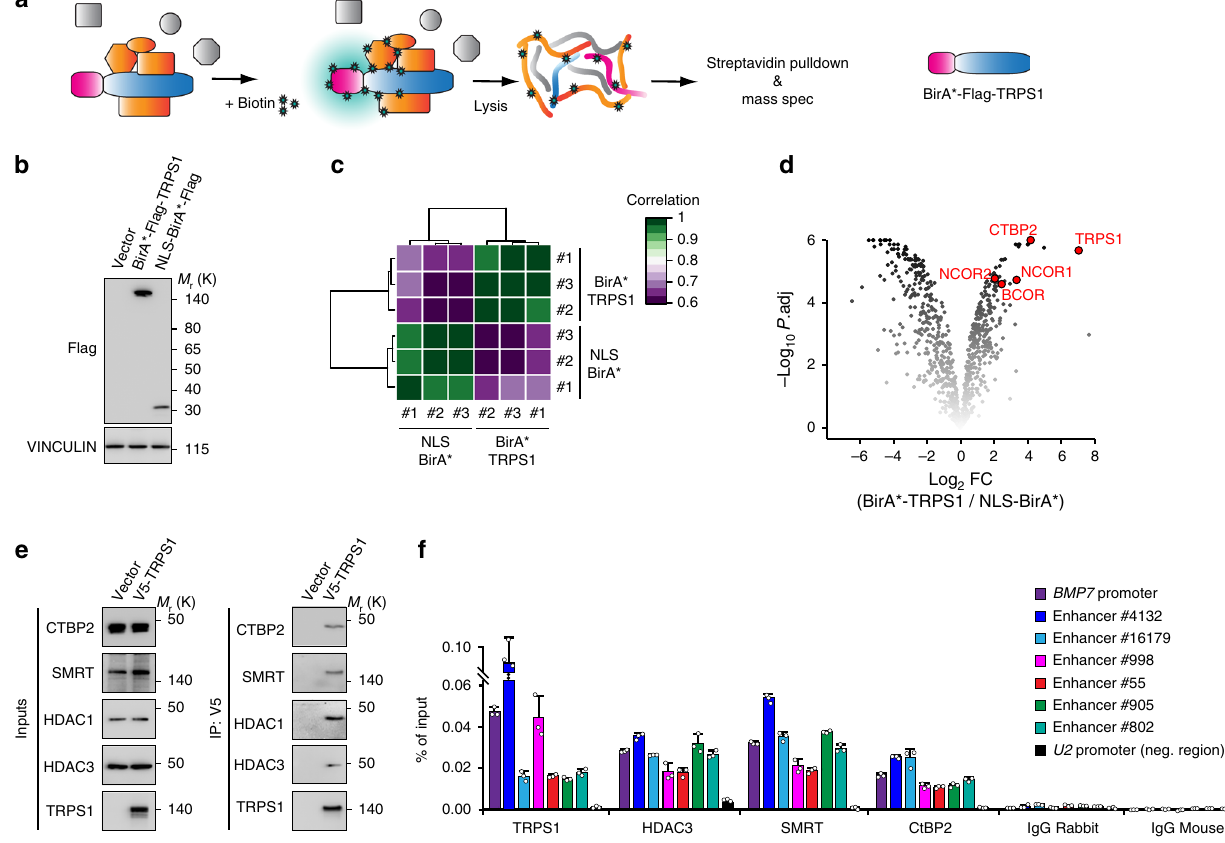
Fig. 5 TRPS1 recruits corepressor complexes to chromatin. a Scheme depicting the BioID method. Mutant BirA (BirA*) fused to TRPS1 biotinylates all proteins in close proximity to the fusion protein after addition of biotin. b Western blot for BirA*-Flag-TRPS1 and the NLS-BirA*-Flag control from transfected 293T cells. Vinculin serves as loading control. c Heatmap clustering analysis (k-nearest neighbour) for the biological triplicates of the BioID experiment. d Volcano plot for nuclear proteins detected in all three BioID replicates. Log2FC: Log2 fold change; P . adj: adjusted P -value. e Western blot for CTBP2, SMRT, HDAC1 in TRPS1 co-immunoprecipitates from 293T cells expressing V5-TRPS1. f qChIP analysis for TRPS1, CTBP2, SMRT and HDAC3 binding at several enhancers and at the BMP7 promoter. The U2 promoter served as a control region. Control IPs were performed with rabbit or mouse IgG, respectively. Error bars represent